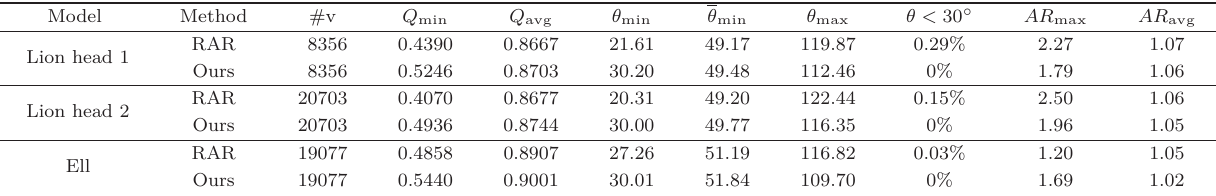
Table 2 Comparative remeshing results, uniform density